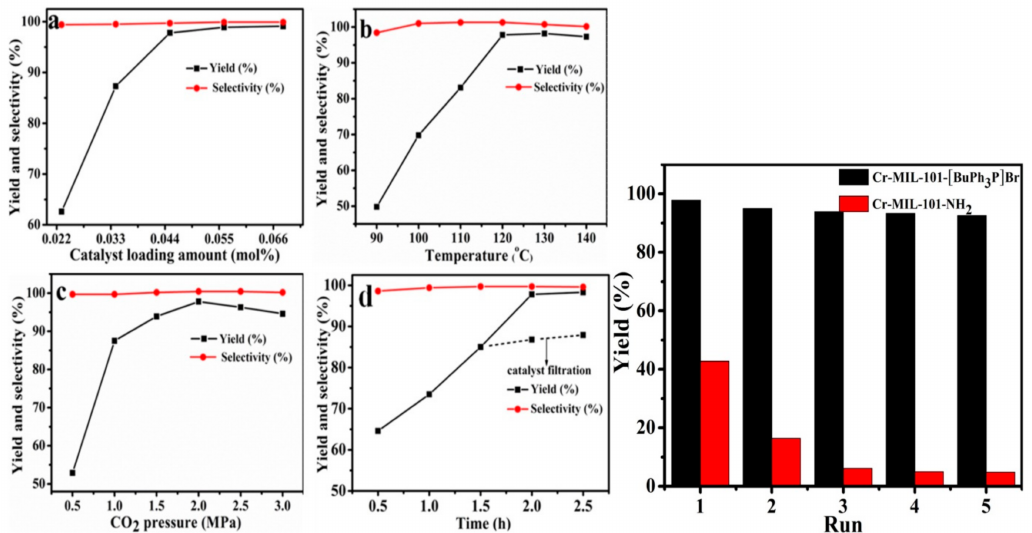
Figure 12. Effect of reaction parameters on the yield and selectivity ( left ) and recyclability test ( right ) under the same reaction condition. ( a ) temperature 120 ◦ C, CO2 pressure 2.0 MPa, ( b ) catalyst 0.045 mol%, CO 2 pressure 2.0 MPa, time 2